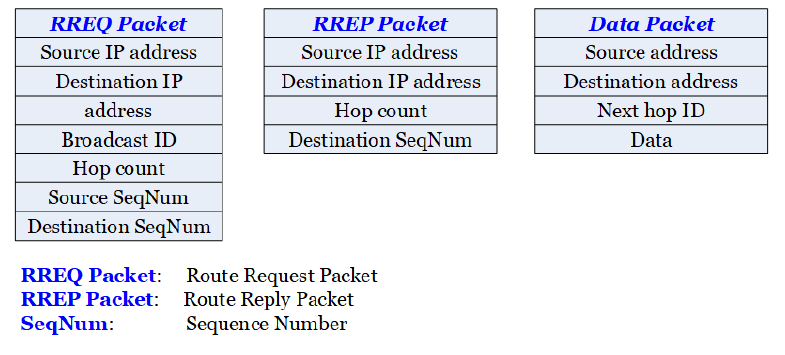
Figure 4. The packet structures used for routing